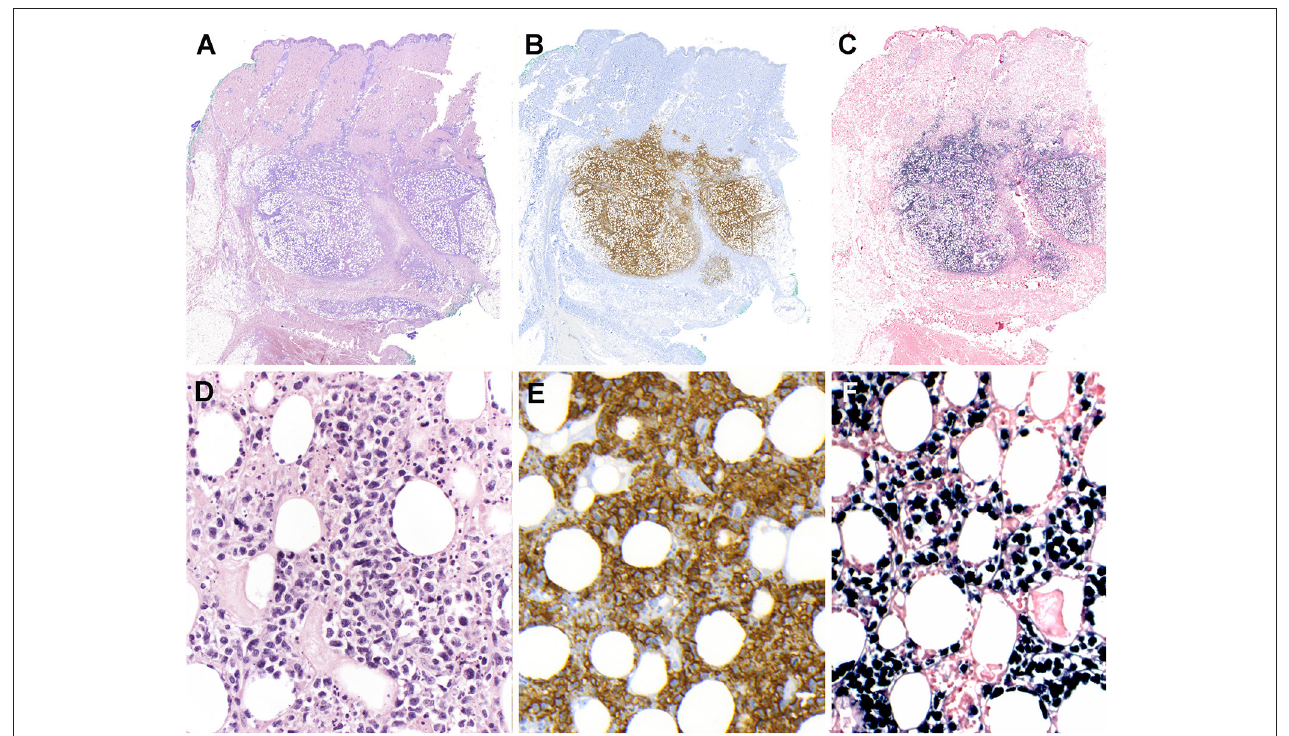
FIGURE 4 | Extranodal, NK/T-cell lymphoma, nasal type in the skin. (A) Panoramic view of a skin biopsy shows a partially circumscribed nodule located in the subcutaneous tissue (H&E, scanned slide); (B) The tumor cells are CD56 positive (immunohistochemistry, scanned slide). (C) The lymphoid cells are positive for EBV-encoded small RNA in situ hybridization (EBER) ( in situ hybridization) (D) The infiltrate is composed of large atypical cells with irregular nuclei. The tumor cells surround the adipocytes revealing a “lace-like pattern” mimicking panniculitis-like T-cell lymphoma. Numerous apoptotic bodies are observed (H&E, 400 × );